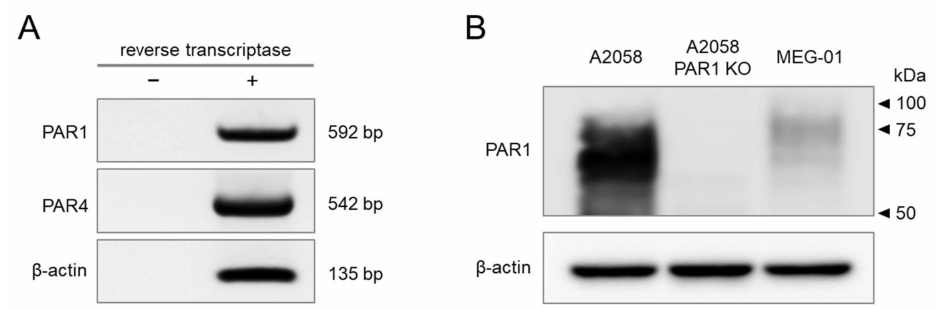
Figure 1. Endogenous expression of PAR1 and PAR4 in MEG-01 cells. ( A ) RT-PCR analysis for PAR1 and PAR4 in MEG-01 cells. PCR products were detected at expected product sizes as indicated. ( B ) Western blot analysis for PAR1 in MEG-01 cells. A2058 and PAR1 knocked out (KO) A2058 cells were used as positive and negative controls, respectively. PAR1 was knocked out by CRISPR/Cas9 in A2058 cells. All experiments were repeated three